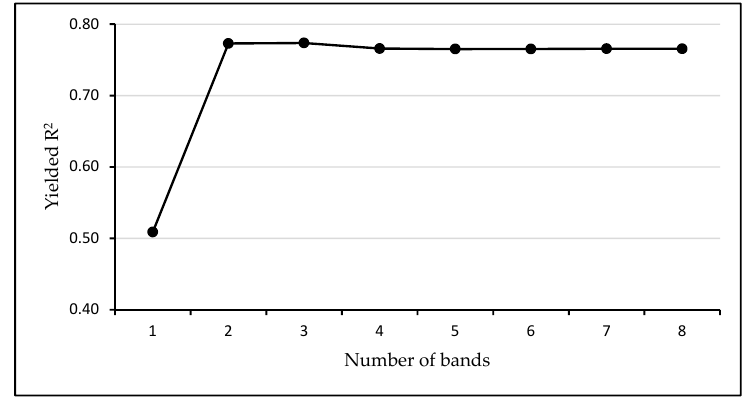
Figure A2. Variation of the models’ R 2 as a function of the number of bands involved in machine learning modelling using the field spectral data resampled to Sentinel-2 bands (FSP_S2). The highest R 2 was achieved using three bands: Centered at 665 nm, 705 nm, and 783 nm.